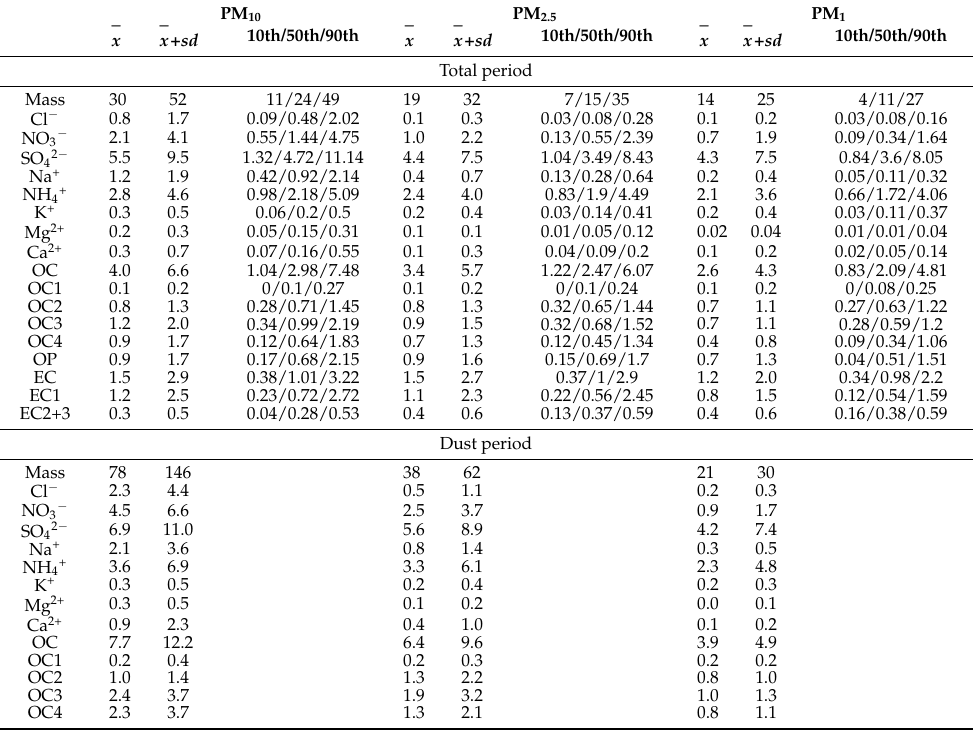
Table 1. Measurement statistics * of mass and chemical constituents of PM 10 , PM 2.5 , and PM 1 at GCO during total period of August 2007~February 2012, dust period, and haze period (unit: µ g/m 3 ). PM 10 PM